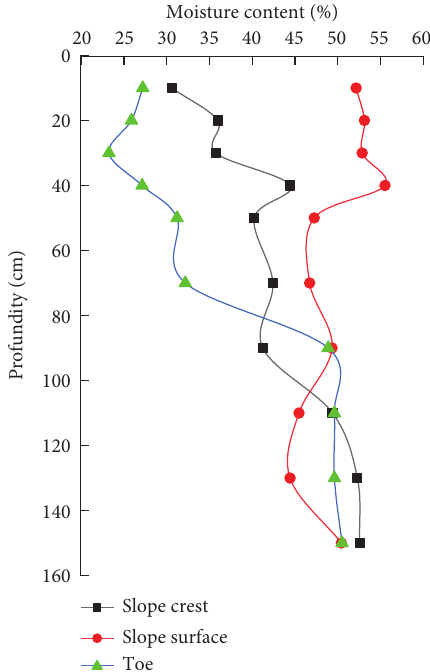
Figure 3: The relationship between water content and depth before monitoring (July 21, 2018).